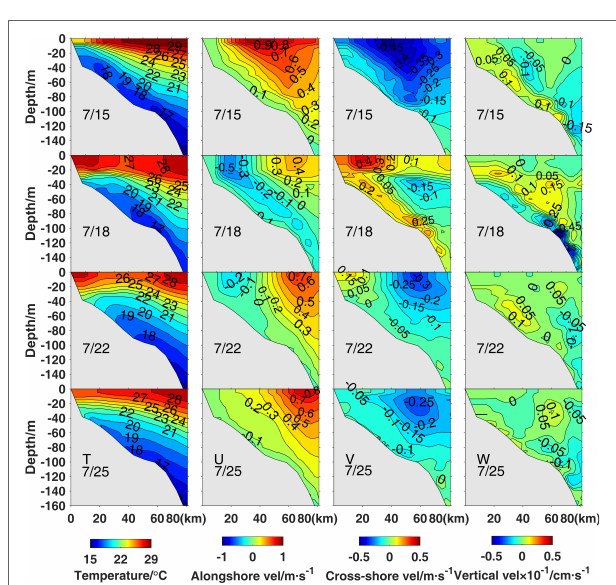
FIGURE 7 | Temperature (T) and velocity in the across-shore (U), along-shore (V), and vertical (W) direction along transect S on July 15, 18, 22, and